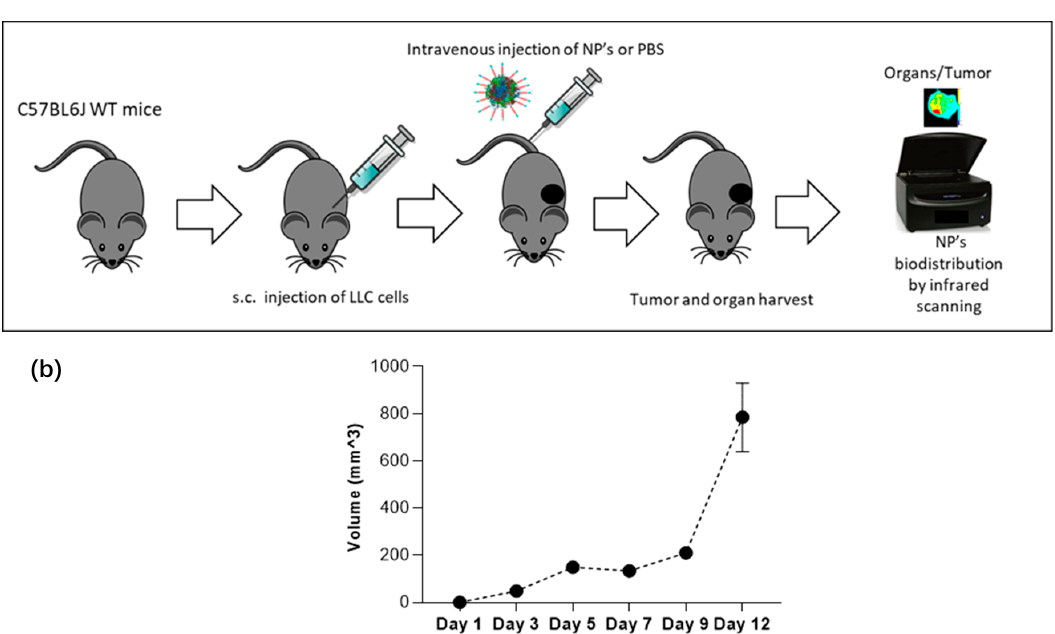
Figure 12. Syngeneic Lewis Lung Carcinoma mouse model. ( a ) C57BL6J wild-type mice were injected subcutaneously with the LLC cell line for an average of 10 d of tumor growth, and 0.5 mg of NPs were injected via tail vein to 25–28 g male mice. After NP injection, mouse tumor and organs were harvested for infrared scanning. ( b ) In this carcinoma mouse model, tumor volume increases in time, and progression is shown from day 1 to day 12.